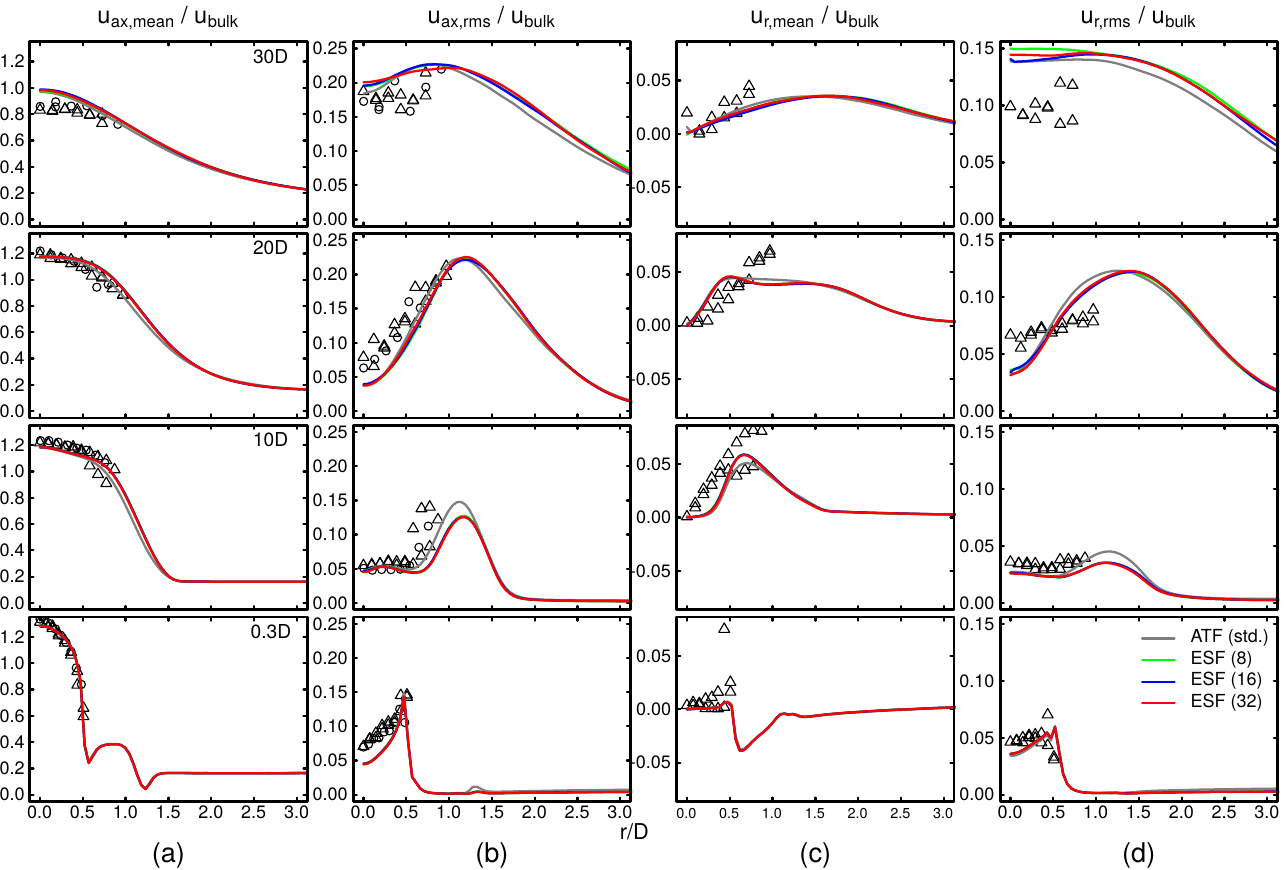
Figure 3. Mean and rms of resolved axial and radial velocity component at various axial distances from the burner exit compared with experimental data ( : Exp. set A; : Exp. set B). Radial velocity statistics only available for experimental set B. ( a ) axial velocity mean; ( b ) axial velocity rms; ( c ) radial velocity mean; ( d ) radial velocity